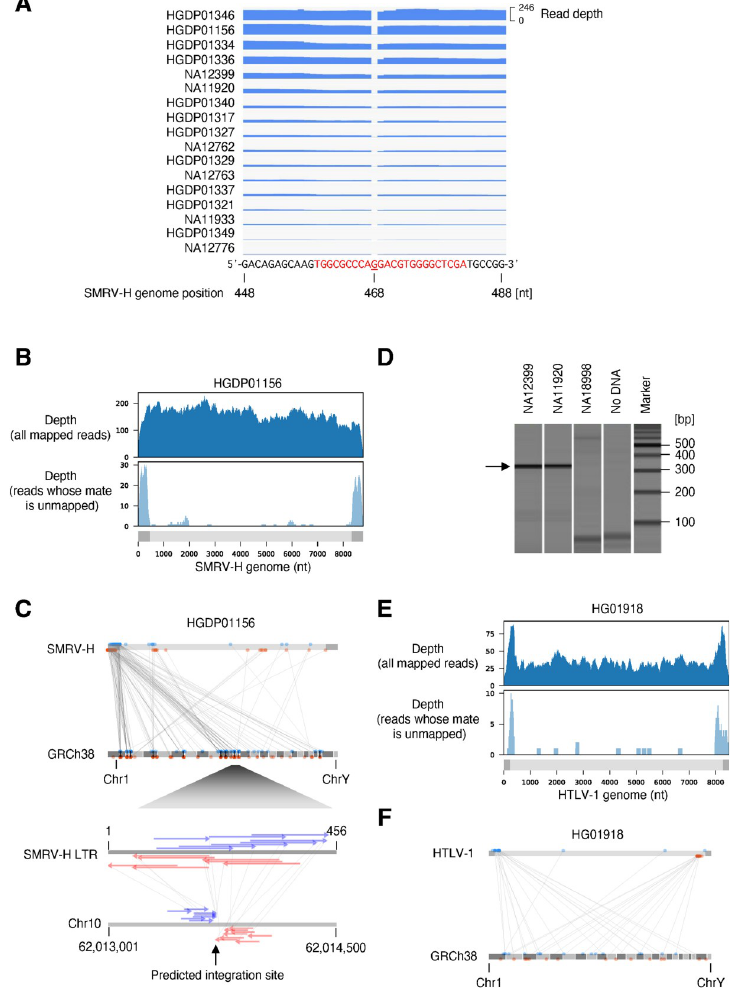
Fig 2. Chromosomal integrations of SMRV and HTLV-1. A. Depth of WGS reads mapping to the primer binding site (PBS) of the SMRV-H genome. Seventeen datasets with at least one read mapping to PBS are shown. One dataset did not have any read mapping to PBS. The PBS of SMRV-H is shown with red characters. In all WGS datasets, the SMRV reads lack the guanosine present at the 468th nucleotide of the SMRV-H genome. B. Depth of HGDP01156 reads mapping to SMRV-H. Upper panel shows the depth of all reads in the dataset mapping to the SMRV-H genome. Lower panel shows the depth of reads mapping to the SMRV-H genome whose mate is not mapped to the SMRV-H genome. Virus genome structure is shown as gray bars. LTR are shown as dark gray rectangles. C. Mapping positions of SMRV-chromosome hybrid reads. Read-1 and Read-2 of a read-pair are connected with a line. All LTR-mapped reads are shown on the left LTR. The lower panel shows the predicted SMRV integration site on chromosome 10. Gray bar in the top of the upper panel represents the virus genome structure. Dark gray rectangles represent LTR. Reads mapping to the forward and reverse directions are shown as blue and red arrows, respectively. D. Detection of SMRV DNA from 1kGP LCLs by PCR. Genomic DNA extracted from the indicated LCLs were used as templates for PCR. WGS datasets from NA12399 and NA11920 are positive for SMRV, while that of NA18998 is negative. E. Depth of HG01918 reads mapping to HTLV-1. Upper panel shows the depth of all reads in the dataset mapping to HTLV-1. Lower panel shows the depth of reads whose pair is not mapped to the HTLV-1 genome. F. Mapping positions of HTLV-1-chromosome hybrid reads. Read-1 and Read-2 of a read-pair are connected with a line. The reads mapping to left LTR was kept when a read was multi-mapped to both left and right LTR. The genome position of reads mapping only to right LTR were replaced to the left